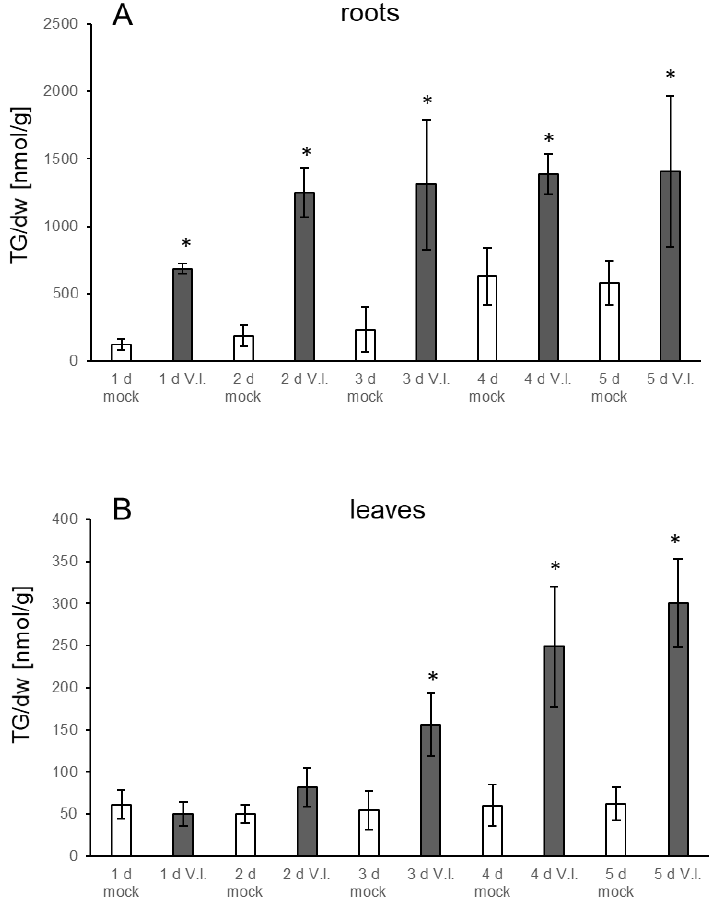
Figure 1. Accumulation of TGs in ( A ) roots and ( B ) leaves of Col-0 in response to treatment of roots with V.l. (dark grey bars) or mock (white bars) at different time points. Shown is the mean of five biological replicates ± sd of the sum of TGs [nmol/g dry weight] with 52 and 54 acyl carbon atoms and one to nine double bonds. Asterisks indicate significant differences between the V.l. treated samples and the corresponding mock treated sample (* p <